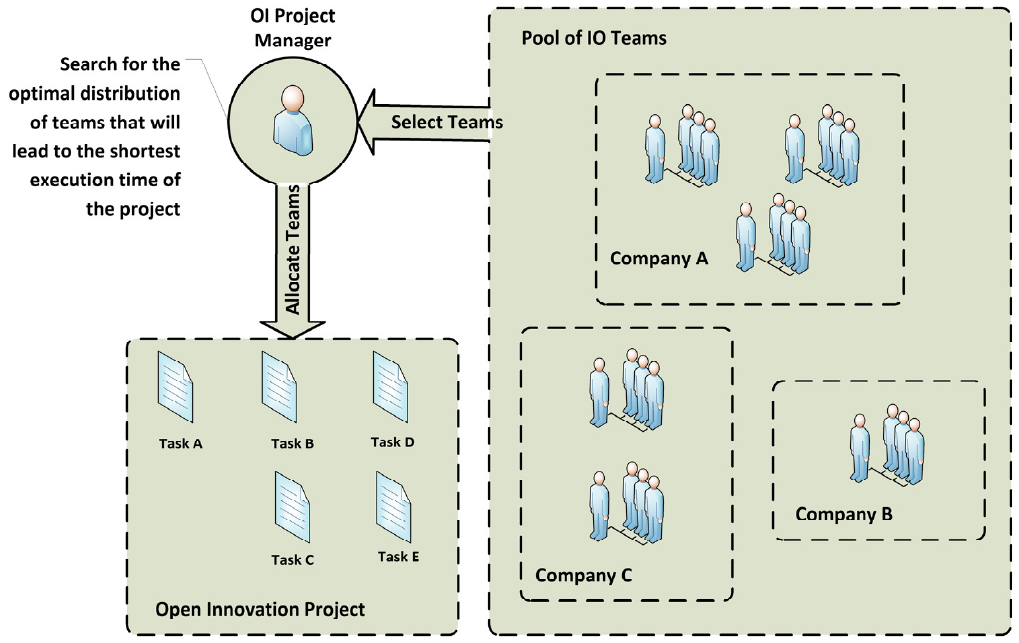
Figure 2. Open innovation allocation of teams’ process.